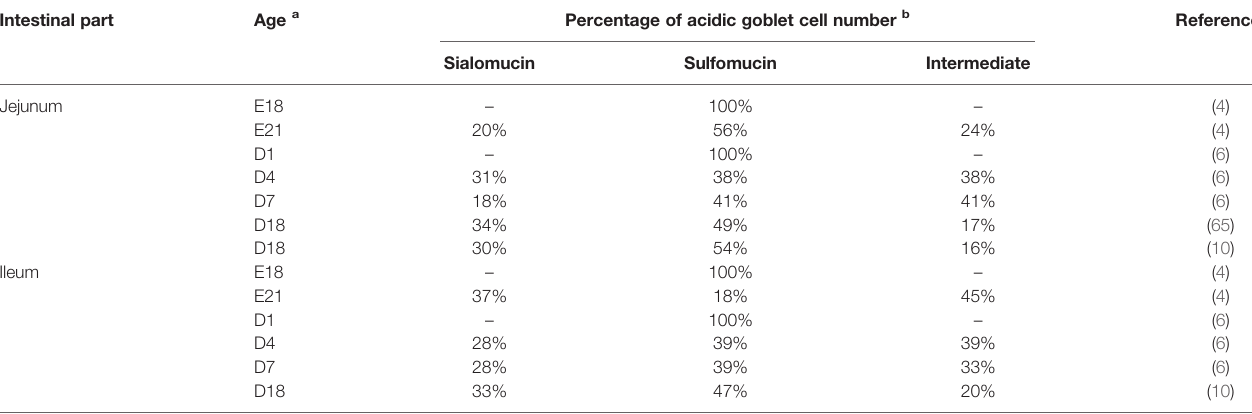
TABLE 3 | Percentage of acidic goblet cell number in the jejunum and ileum of broiler at different ages. Intestinal